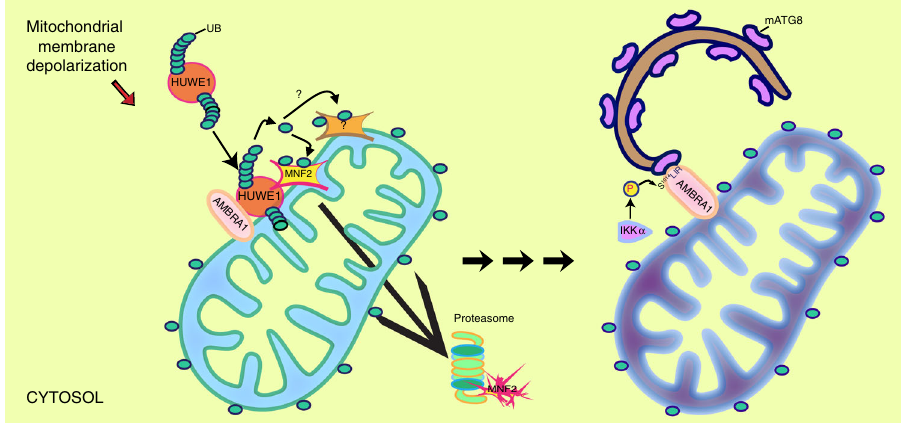
Fig. 8 AMBRA1 regulates mitophagy at two critical steps. Upon mitophagy stimulation, AMBRA1 mediates the HUWE1 E3 ubiquitin ligase translocation from cytosol to mitochondria (light blue). AMBRA1 acts as a cofactor for HUWE1 E3 ubiquitin ligase activity, favouring its binding to its substrate MFN2 (and maybe other OMM substrates) and targeting it to the proteasome. This event is crucial and required for AMBRA1-induced mitophagy. In a second step, in analogy with other mitophagy receptors, AMBRA1 is phosphorylated at S1014, fl anking its LIR motif, in order to be able to interact with mATG8s. The fi nal outcome is the engulfment of damaged mitochondria (dark blue) into autophagosomes. This post-translational modi fi cation is controlled by IKK α kinase upon mitophagy stimulation. Reproduced from ref. 71 with permission from